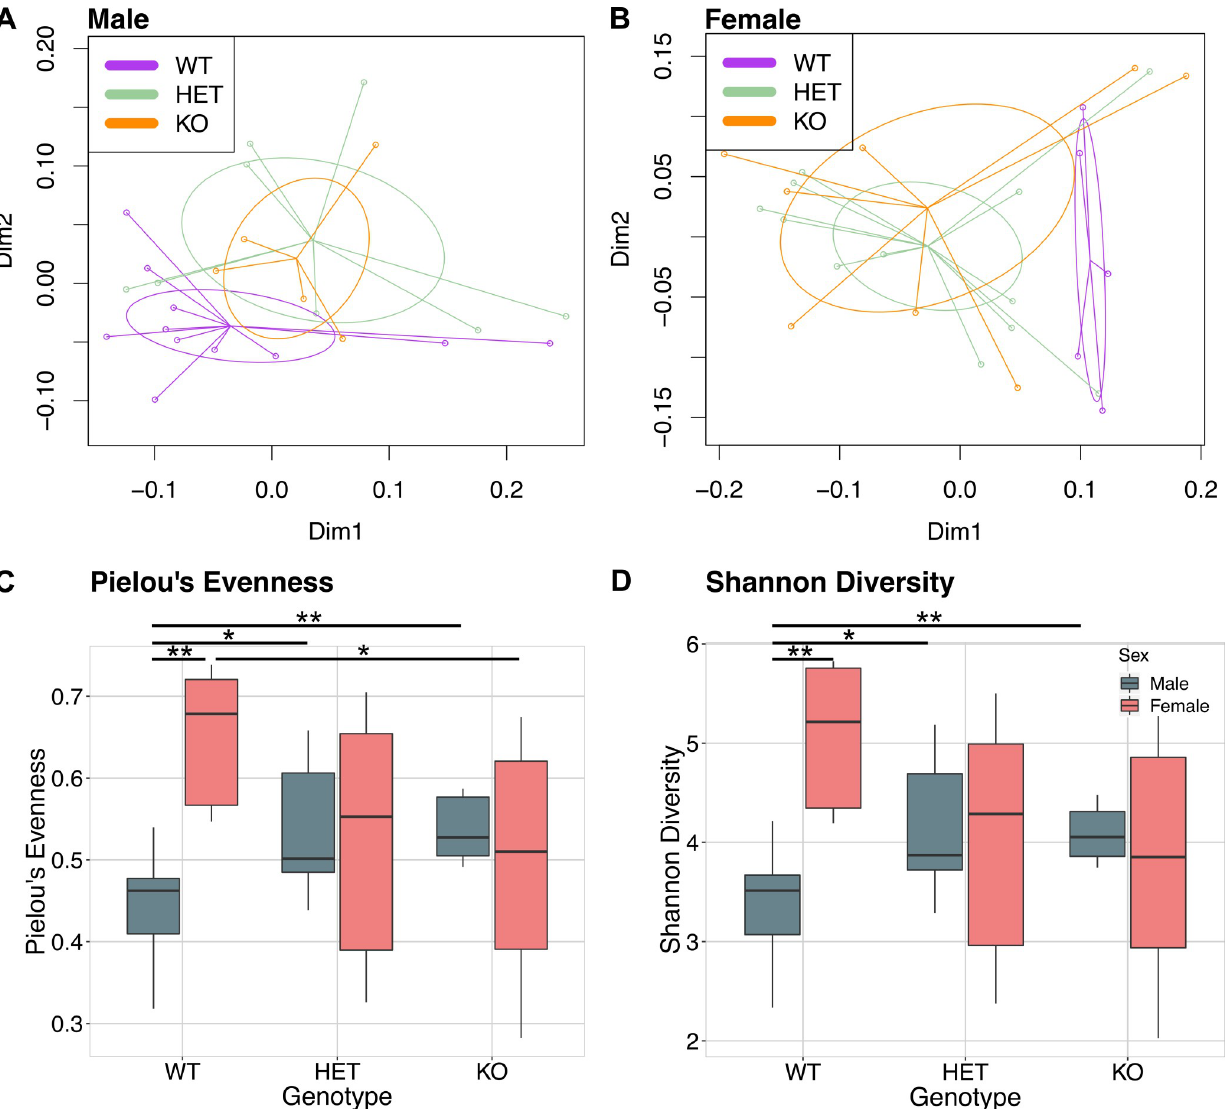
Fig 6. Sex specific effects of Znt7 knockout on overall bacterial community structure. (A and B) Principal coordinate analysis of the weighted UniFrac distance measures between microbial communities from Znt7 +/+ (WT), Znt7 +/- (HET) and Znt7 -/- (KO) in (A) male and (B) female mice. (C and D) Boxplots of microbial community evenness, represented by Pielou’s evenness index and Shannon diversity index respectively. � , p < 0.05; �� , p < 0.01.